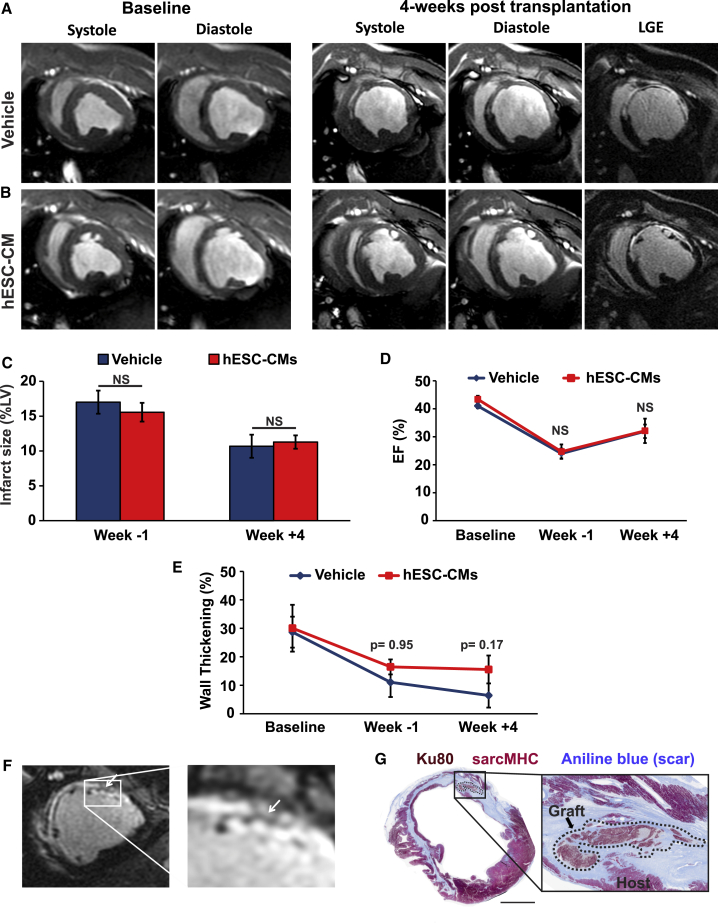
Infarct Size, LV Contractile Function, and Graft Geometry by Cardiac MRI in hESC-CM versus Vehicle RecipientsInfarcted pigs receiving either hESC-CMs or vehicle underwent MRI scans at baseline (prior to MI), 1 week prior to transplantation (2 weeks post MI), and 4 weeks post transplantation (7 weeks post MI).(A and B) Short-axis slices from representative vehicle (A) or hESC-CM (B) recipients acquired during systole and diastole at either baseline or 4 weeks post transplantation. Rightmost panels also show LGE-MR images to highlight hyperenhanced scar tissue.(C) Infarct size by LGE-MRI in infarcted pigs receiving hESC-CMs versus vehicle.(D) LVEF in infarcted pigs receiving hESC-CMs versus vehicle.(E) Regional wall thickening in infarcted pigs receiving hESC-CMs versus vehicle. The number (n) for (C) to (E) can be found in Table S2.(F) LGE-MRI images showing strands of non-enhancing tissue identified within the hyperenhanced infarct scar of a representative hESC-CM recipient at 4 weeks post transplantation.(G) Histological section corresponding to the MR images depicted in (F). Sections were stained to identify sarcMHC (red), human-specific Ku80 (brown), and scar (blue), confirming the presence of human myocardial implants with a geometry matching the strands identified by LGE-MRI. Scale bar, 1 mm.